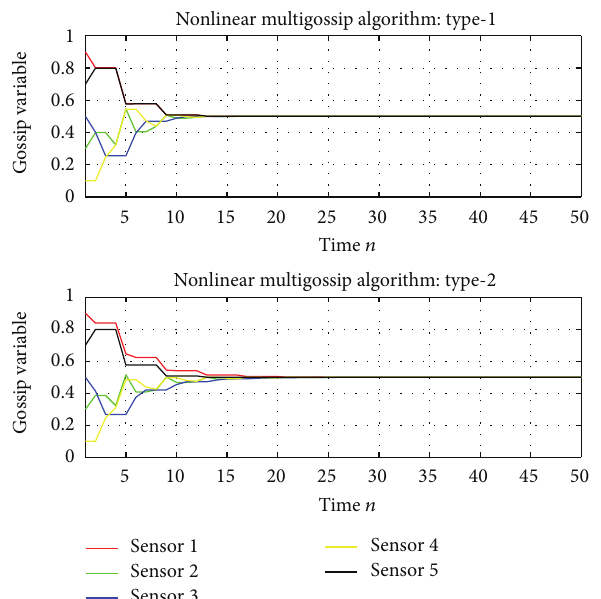
Figure 3: Simulations of the multigossip algorithm for type-1 and